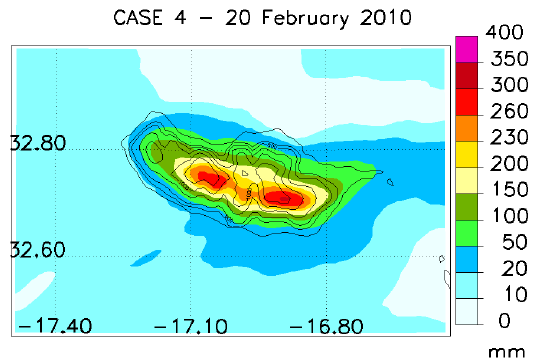
1 Figure 9. Forecast of accumulated precipitation for 20 February 2010 is represented by the 2 Fig. 9. Forecast of accumulated precipitation for 20 February 2010 shaded areas, while the solid lines represent Madeira orography (m). The orography is 3 is represented by the shaded areas, while the solid lines repre- simulated from GTOPO30 database with 1 km resolution. 4 sent Madeira orography (m). The orography is simulated from GTOPO30 database with 1km